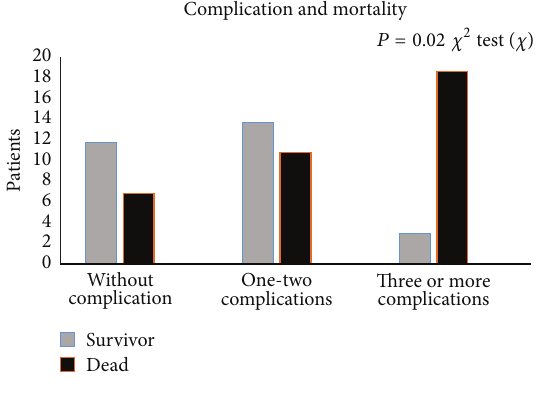
Figure 1: Complication and